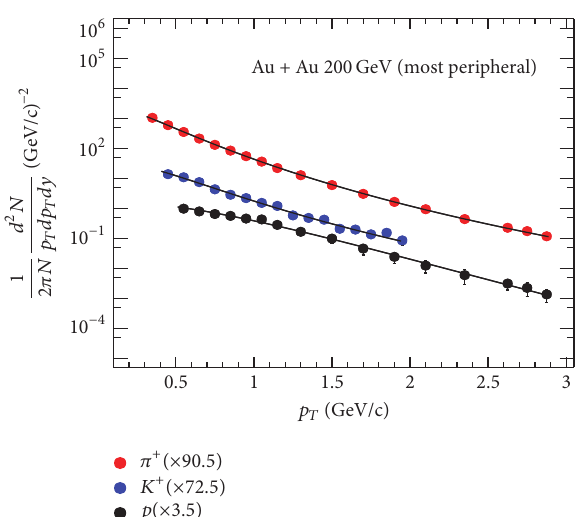
Figure 11: Fitting of invariant 𝑝 𝑇 spectra with Tsallis distribution using (7) for 𝜋 + [18], 𝐾 + [18], and 𝑝 [18] in most peripheral Au + Au collisions at √𝑠 NN = 200 GeV. Symbols represent the data points and line is the fit